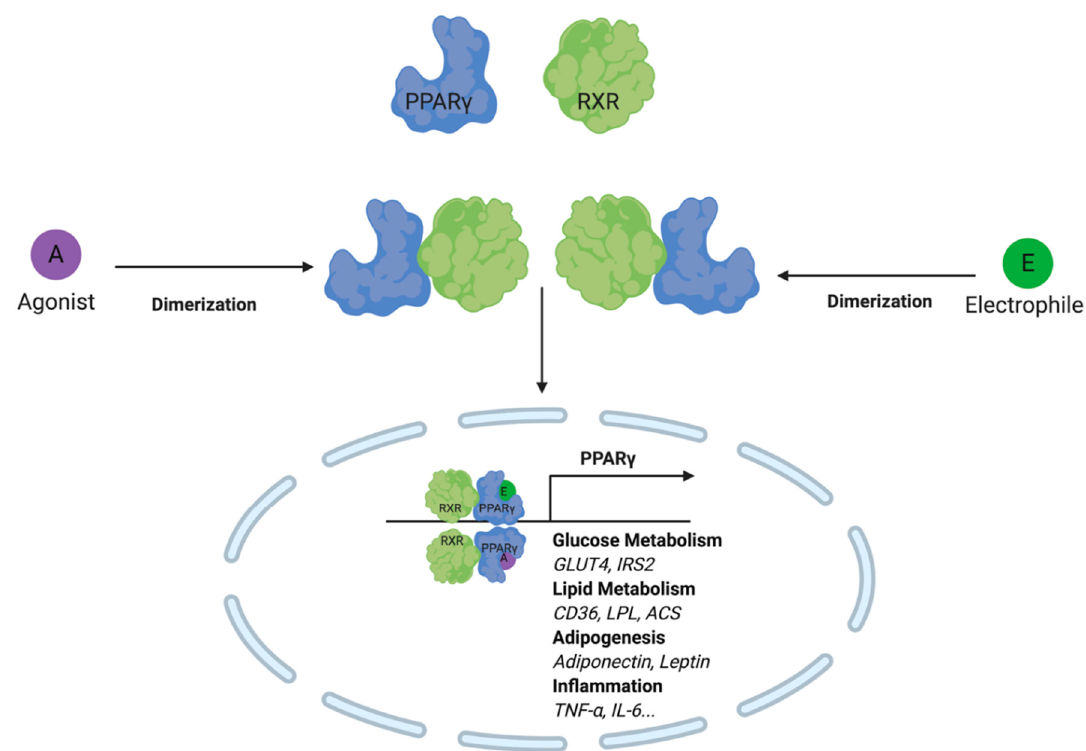
Figure 6. Lipid electrophiles activate PPAR γ by creating an adduct at the c-terminal region ligand- binding domain. Similar to PPAR γ agonists, lipid electrophiles activate the transcription factor and trigger target gene expression. Target genes include those involved in glucose metabolism, lipid metabolism, adipogenesis and